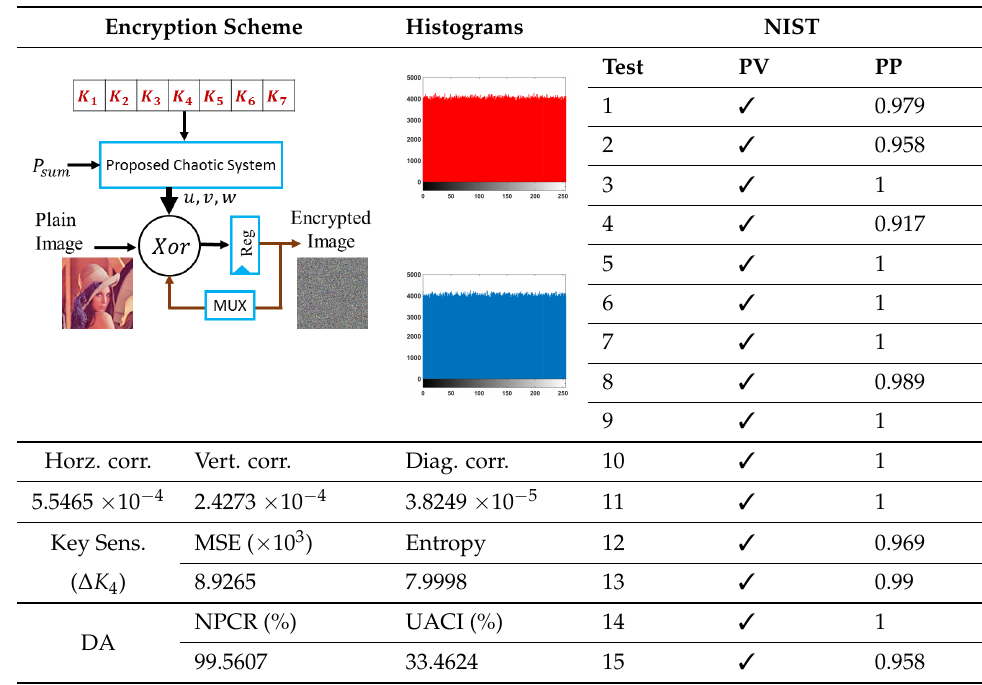
Table 3. Encryption scheme and its performance